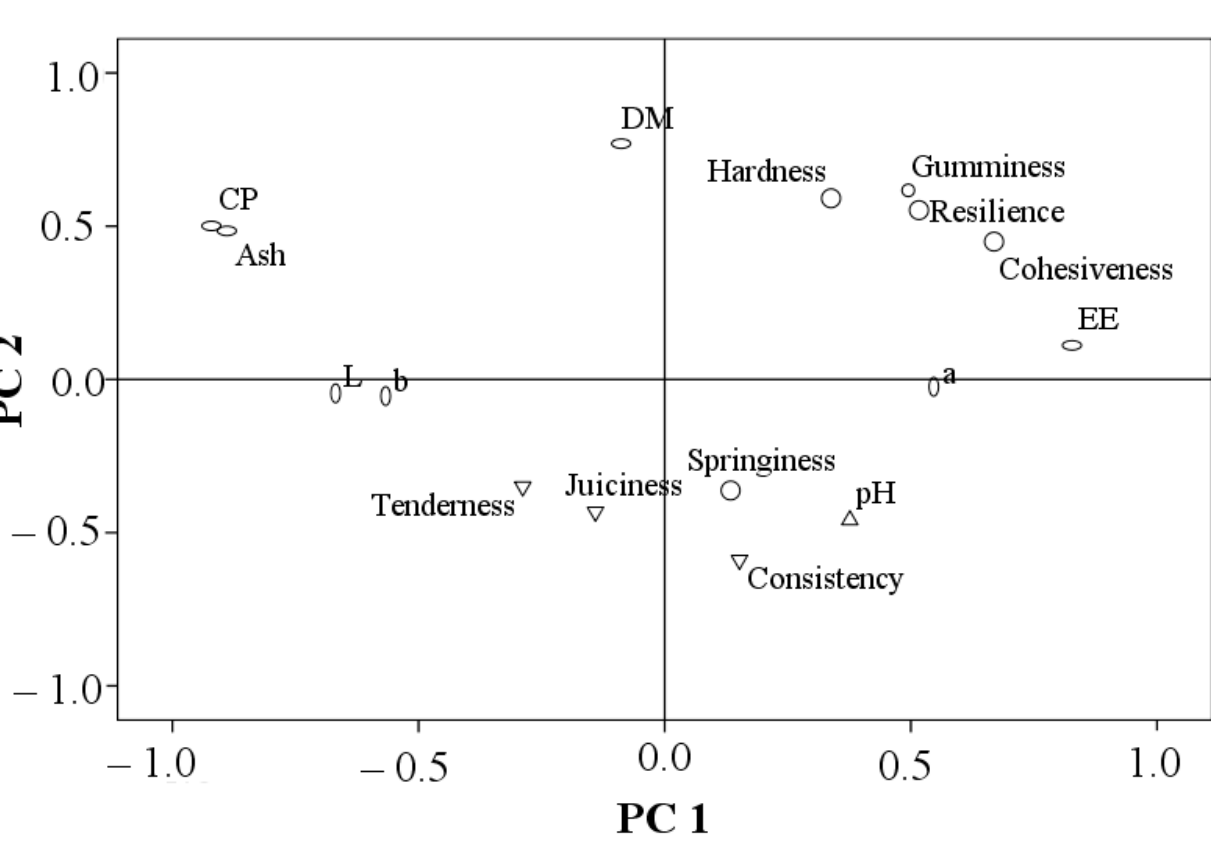
Figure 1. Principal component loading based on the chemical composition, L*, a*, b* color parameters, textural parameters, and sensory characteristics. L*: luminosity parameter; a*: redness; b*: yellowness; DM: dry matter; CP: crude protein; EE: ether extractives.